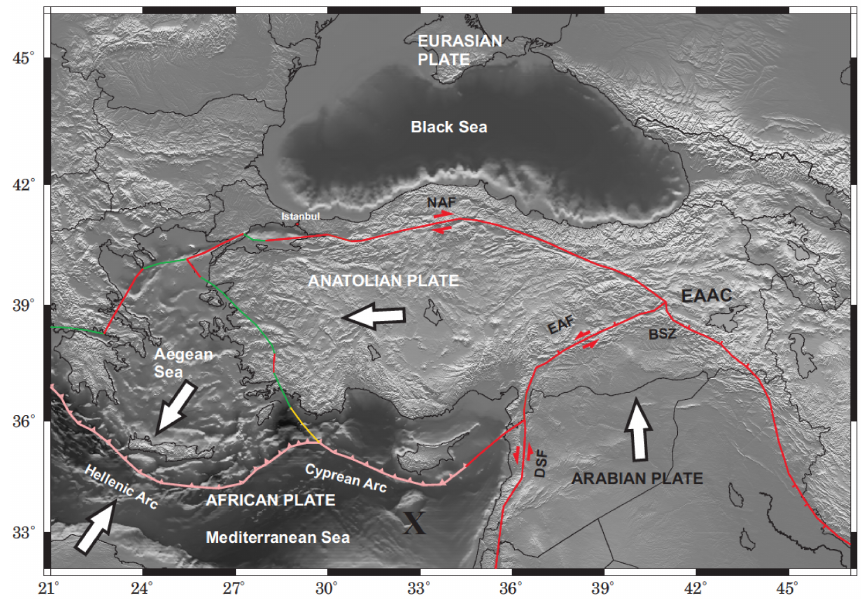
Figure 1. Tectonic map of the study area. The major plate boundary data are taken from Bird (2003). Subduction zones are pink, continental transform faults are red, continental rift boundaries are green, and spreading ridges boundaries are yellow. EAAC, NAF, EAF, and DSF are the East Anatolian Accretionary Complex, North Anatolian Fault, East Anatolian Fault, and the Dead Sea fault, respectively. X marks the Eratosthenes